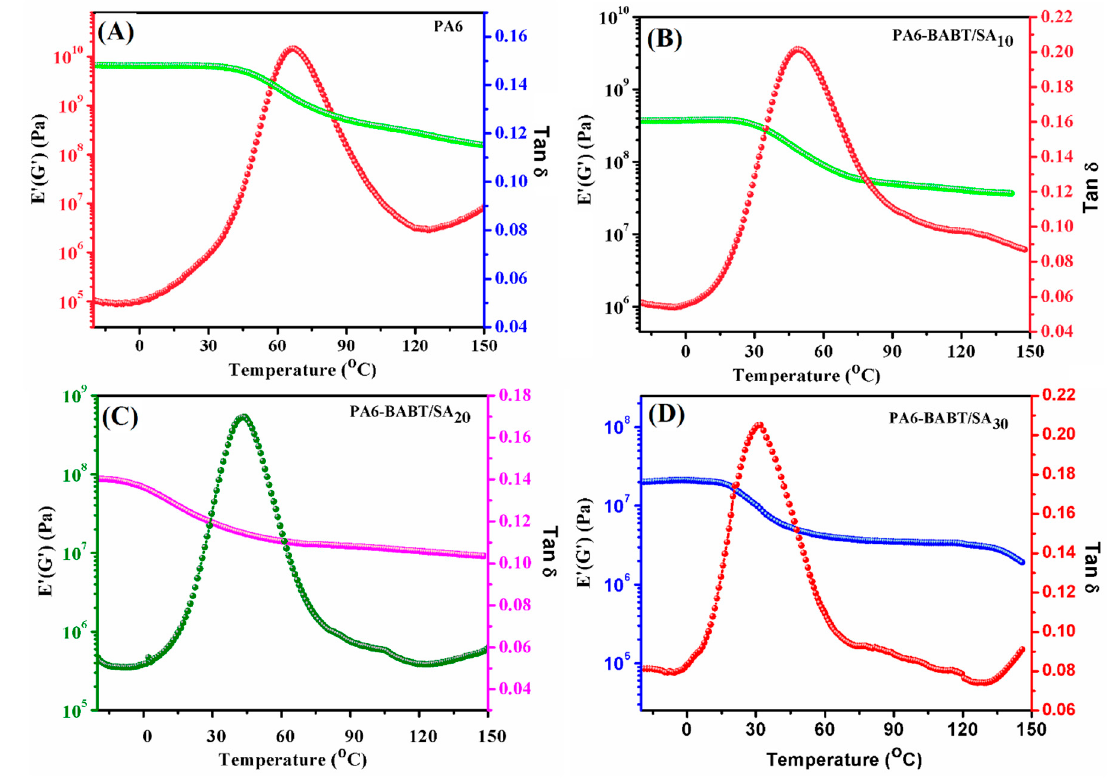
Figure 14. Dynamic mechanical analysis (DMA) curves (Tan δ and storage modulus E’) of ( A ) PA6 and ( B – D ) PA6-BABT/SA copolyamides. Table 5. Mechanical properties of PA6 and PA6-BABT/SA copolyamides.